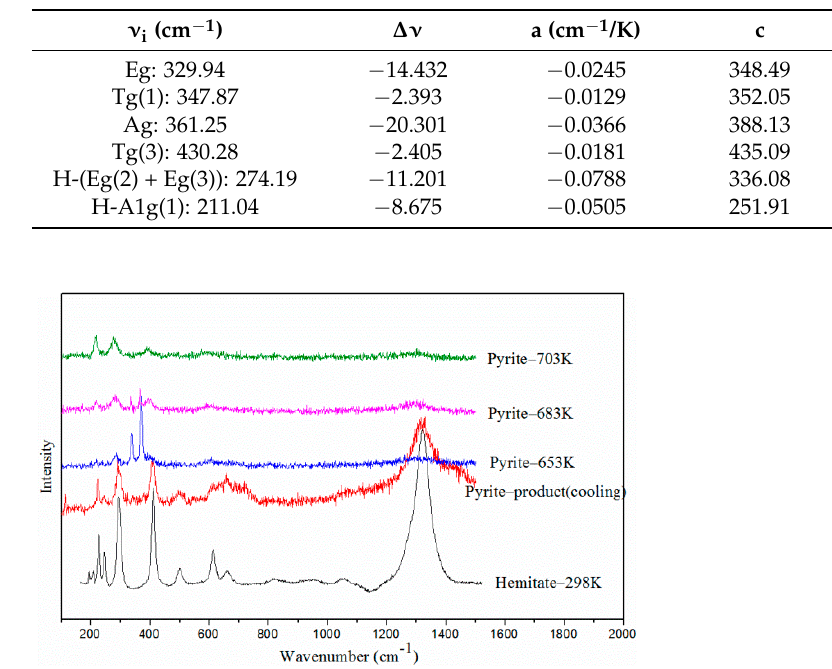
Table 4. Variable modes of Raman bands ( ∆ ν ) of pyrite with increasing temperature according to ν i = a T + c. ν i and ∆ ν are in cm − 1 , T in K, a in cm − 1 /K, c is a constant, and R 2 is the correlation coefficient.